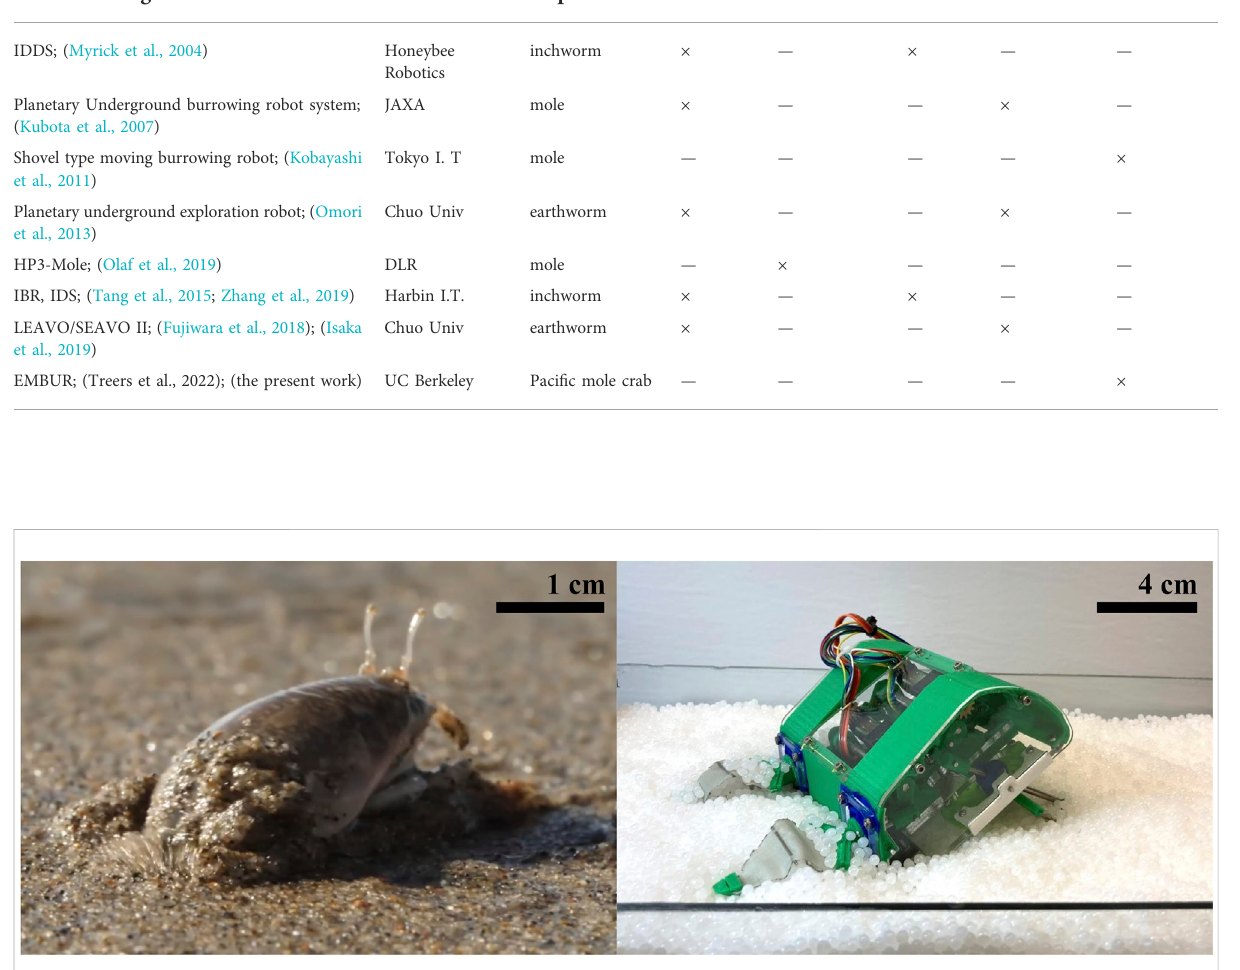
TABLE 1 Summary of existing vertical self-burrowing robots We summarize efforts to create self-burrowing robots capable of vertical locomotion in granular media, drawing from work in Wei et al. (2021). Publication information, biological inspiration, and burrowing mechanisms utilized are indicated. Notably, very few prior works have been successful in utilizing excavative modes for vertical burrowing. Vertical, self-burrowing robot